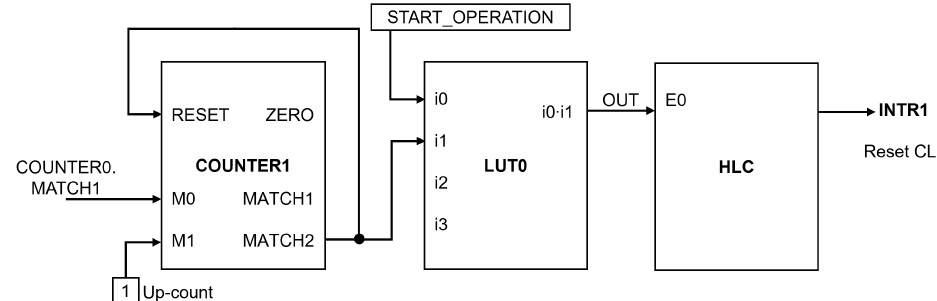
Figure 13. CLB structure for CLB_RESET.